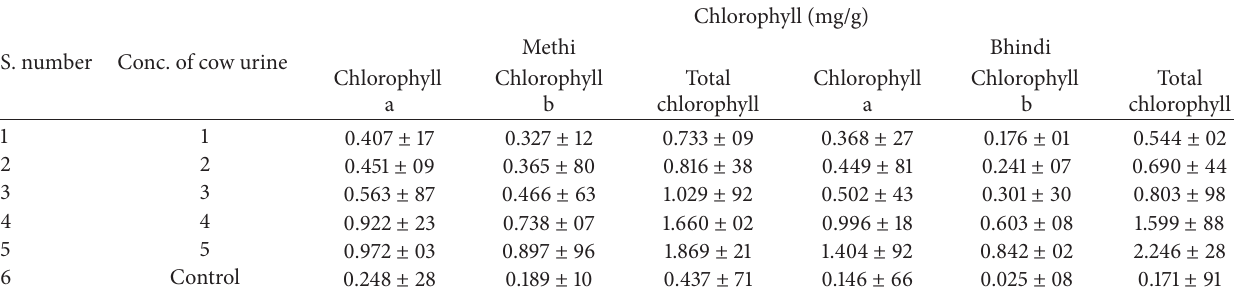
Table 6: Chlorophyll estimation of Trigonella foenum-graecum (Methi) and Abelmoschus esculentus (Bhindi) sprayed with different concentrations of cow